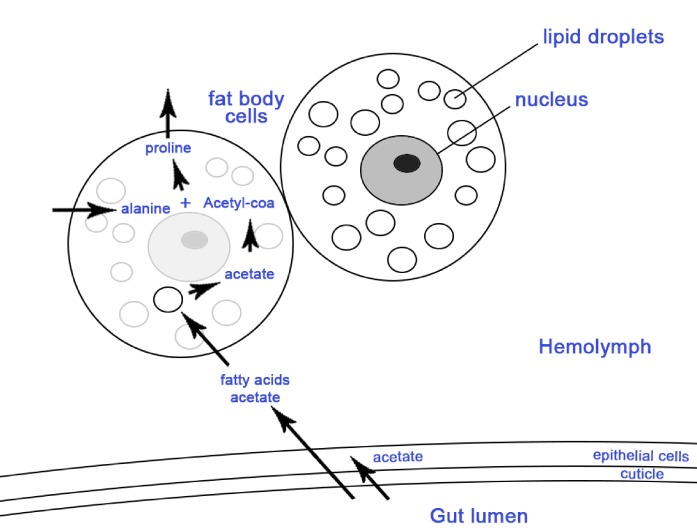
Schematic representation of two ant fat body cells and the process of storing acetate in the lipids of the fat body cells.Arrows show metabolic processes where metabolites from the gut pass to the fat bodies for storage to be used in periods of nutritional stress when they are converted to high energy nutrients such as proline and triglycerol which are released in the hemolymph (reviewed in (Arrese and Soulages, 2010)). Considering that the midgut and ileum are sites that are both colonized by the EntAcro1 and where acetate is most likely produced (Figure 4—figure supplement 1), and that previous work has shown that epithelial cells are lining the gut and the surrounding fat body cells (Wigglesworth, 1972), it seems likely that gut epithelial cells and fat body cells absorb the acetate produced by EntAcro1.